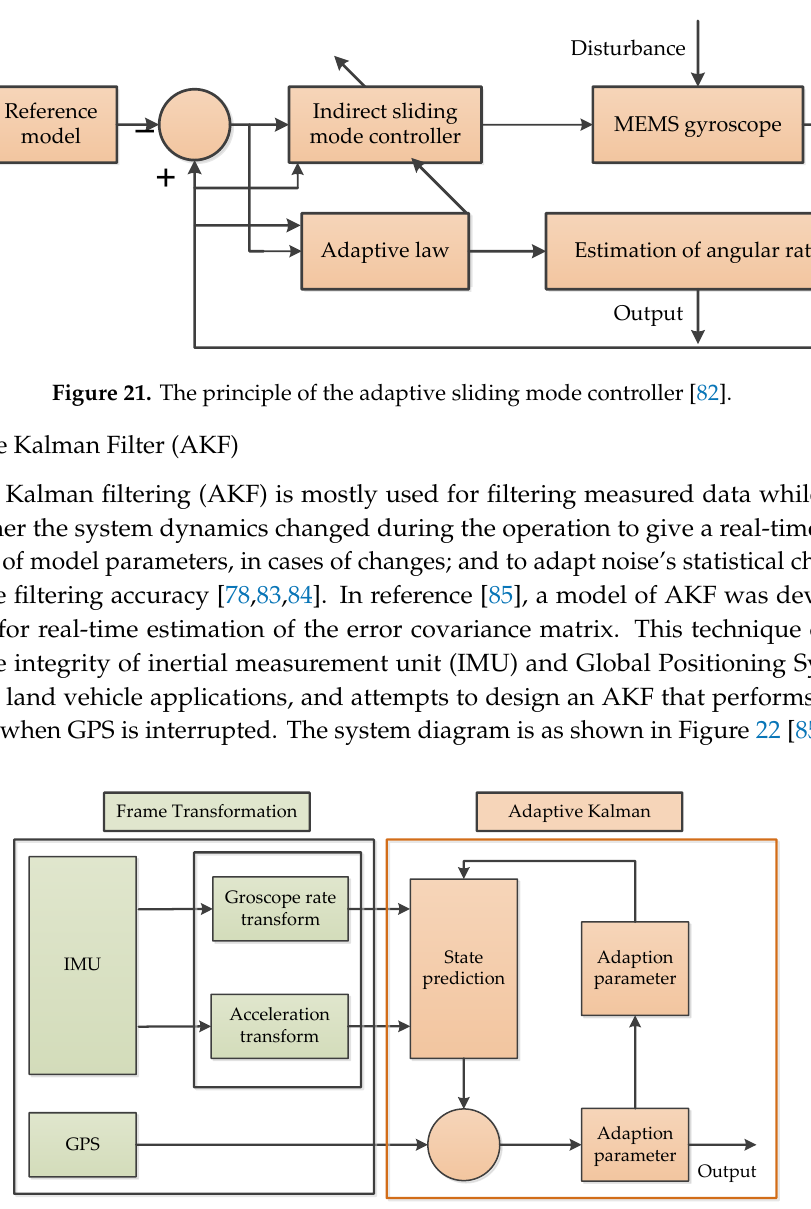
Figure 22. The system diagram of adaptive Kalman filtering [85].